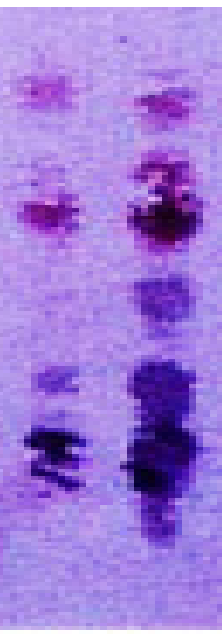
Figure 8. Double eastern blotting for ginsenosides contained in Panax species (author’s unpublished data) The thin-layer chromatography plate was developed with 1-butanol/water/acetic acid (7/2/1). The staining substrates were 4-chloro-1-naphthol (blue color for protopanaxadiol-type ginsenosides) and 3-amino-9-ethyrcarbazole (pinkish color for protopanaxatriol-type ginsenosides).